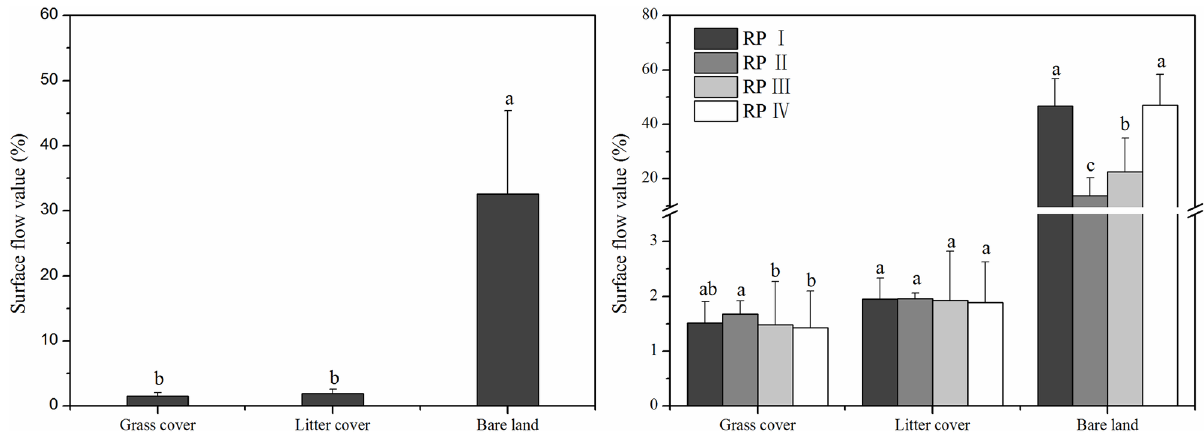
Fig 5. Surface flow values of the three land cover types under different rainfall patterns.